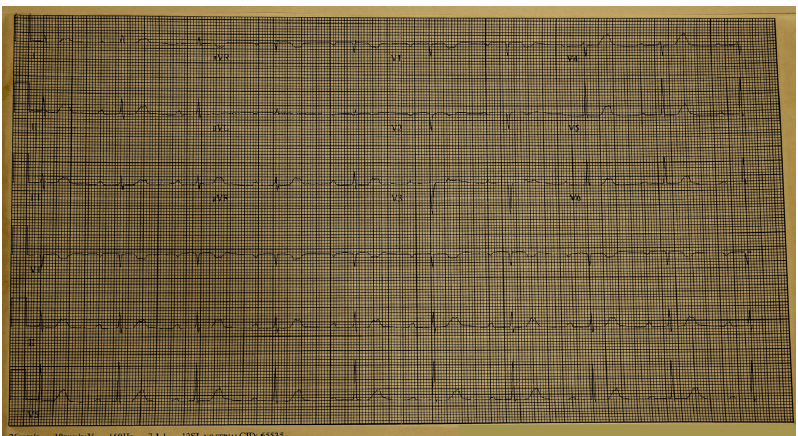
Figure 2: The patient’s admitting EKG showing sinus tachycardia with second-degree AV block with 2 : 1